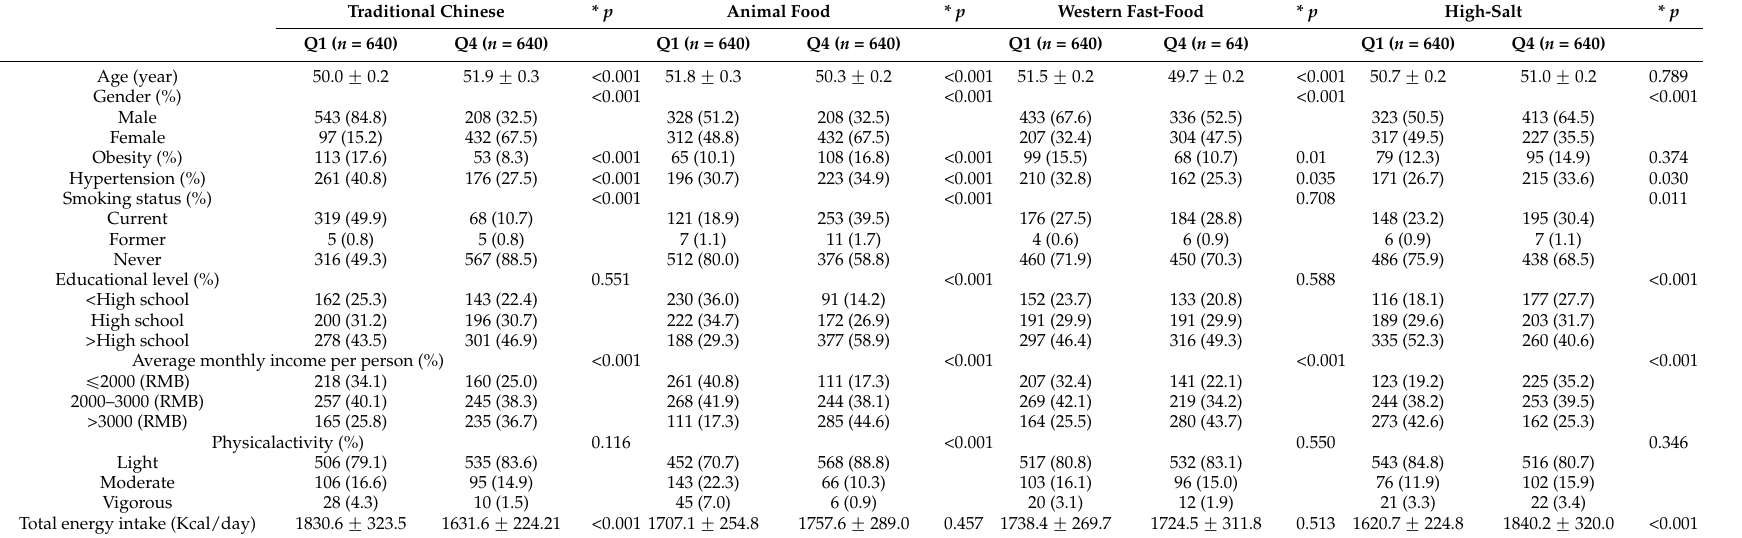
Table 2. The general characteristics of the study participants across quartile (Q) categories of dietary pattern scores in the